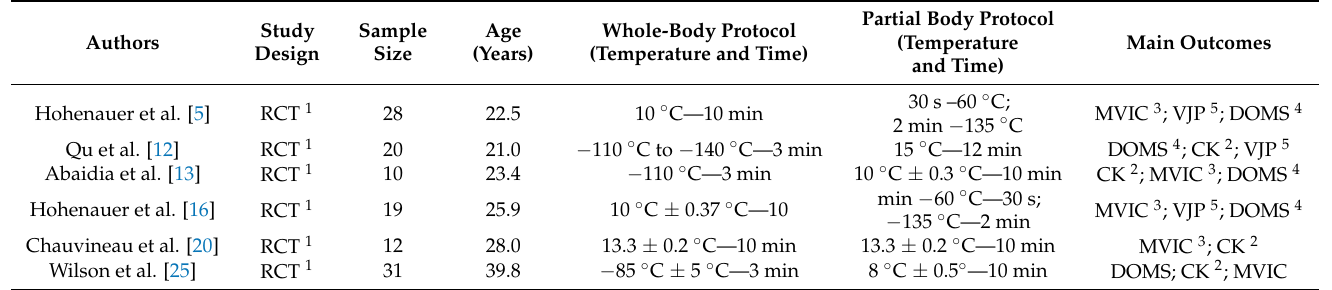
Figure 1. Prisma flowchart diagram. WBC: Whole-body cryotherapy (WBC); PBC: Partial-body cryotherapy. Table 1. Papers included in the quantitative